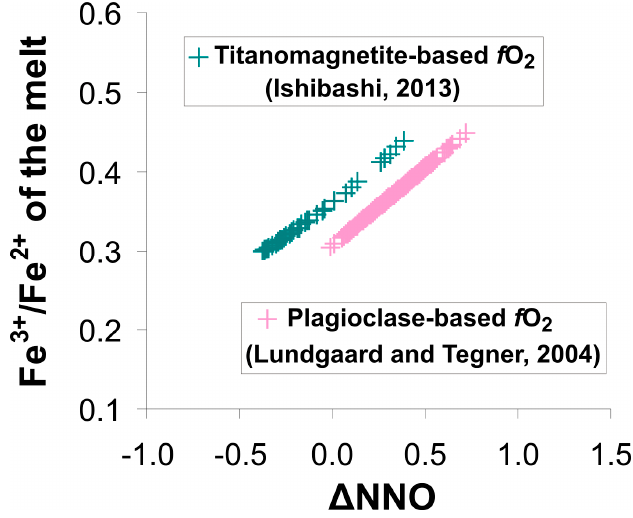
Figure 7. Oxygen fugacity of the sill magma estimated by (1) the titanomagnetite-based oxygen barometer (error ± 0.5 log unit) of Reference [76], integrating the Fe 2+ -Fe 3+ partitioning between spinel and melt [77] with the Fe 3+ /Fe 2+ ratio and f O 2 [78], and (2) the formalism of Reference [80], relating the redox state of iron in the melt (error ± 0.1 log unit) with the anorthite content in plagioclase.